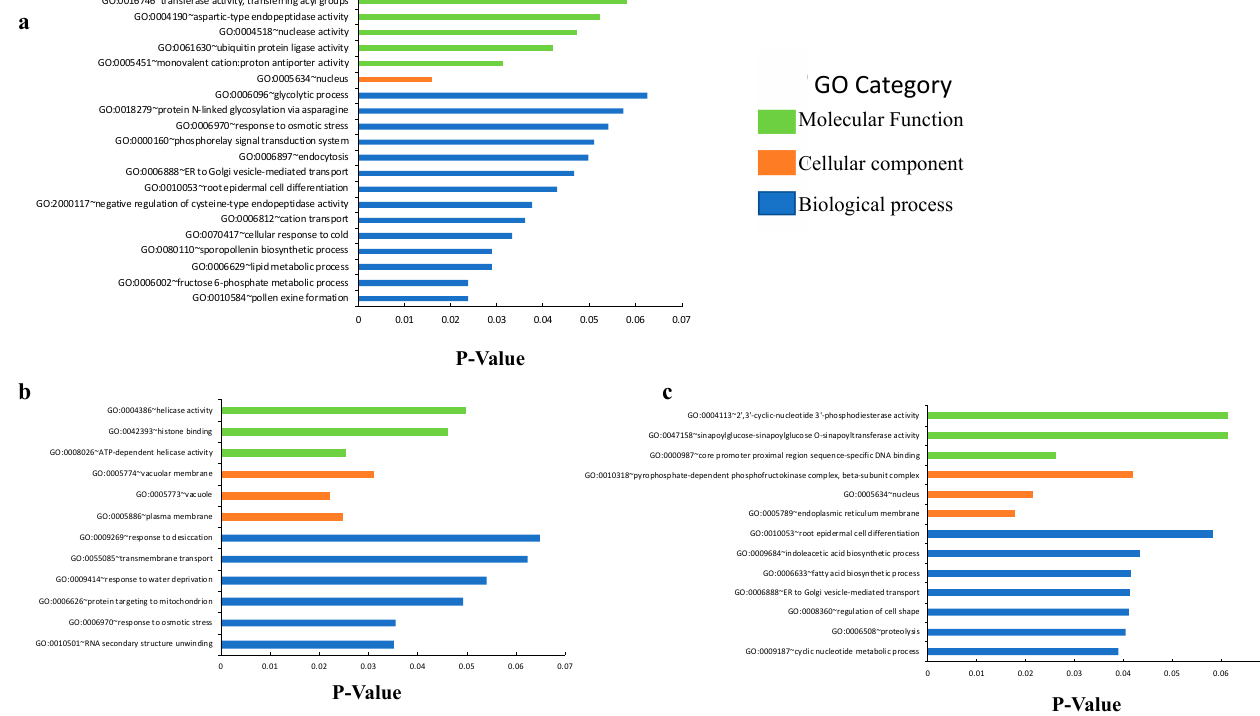
Figure 8. Significantly enriched Gene Ontology (GO) categories (biological process, cellular component, and molecular function): ( a ) associated with differentially expressed genes from lea13 microarray data, ( b ) associated with upregulated genes from lea13 microarray data, and ( c ) associated with downregulated genes from lea13 microarray data. Fisher Exact p -Value = 0 represents perfect enrichment. Usually, p -Value is equal to or smaller than 0.05 to be considered strongly enriched in the annotation categories.